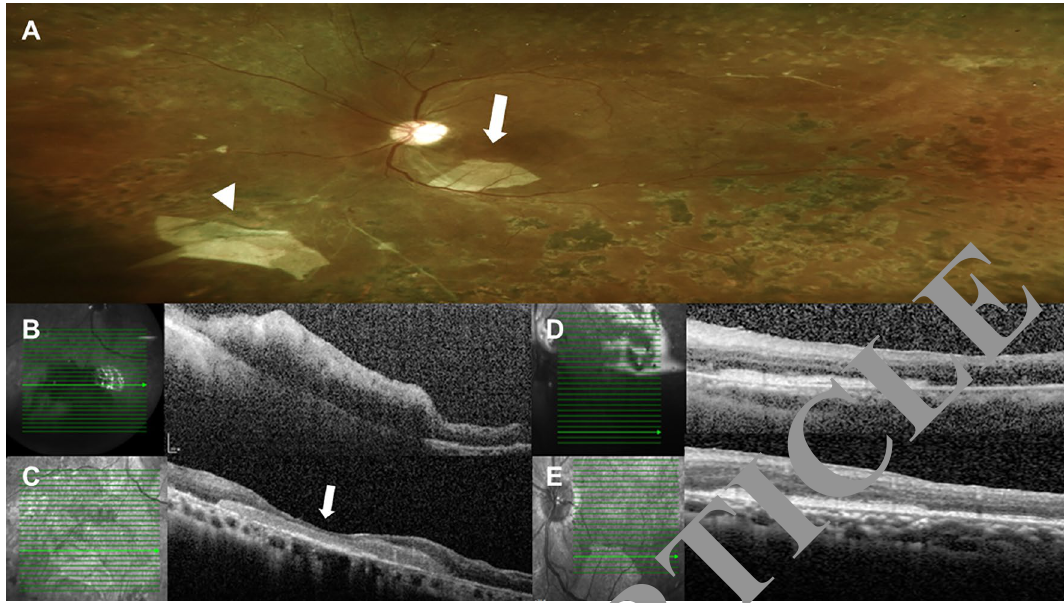
Figure 2. Postoperative color fundus photograph and serial optical coherence tomography (OCT) exams of case 7. ( A ) Color fundus photograph showed the one large retinal break securely covered by a human amniotic membrane (hAM) graft (arrow head). Also, there was one pice of hAM dislocated at the subretinal space within the vascular arcade intraoperatively (arrow). ( B ) Ten days after surgery, OCT scans over the location of retinal break showed the hAM graft covering the large break. ( C ) Six months later, follow-up OCT showed marked retina and glial tissue growing to cover the retina defect (arrow). And the graft remained stable without change in size. ( D ) Ten days after surgery, OCT scans of the dislocated subretinal hAM graft showed a sheet of hAM under the retina. ( E ) Six months later, the follow-up OCT revealed that there was no atrophy of the retina